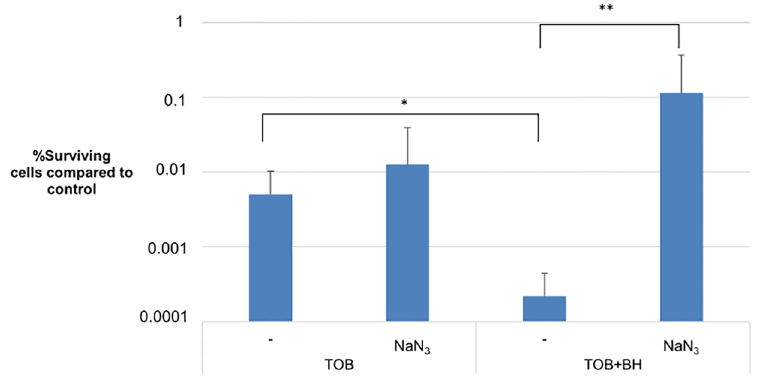
Fig 6. Effect of electron transport chain inhibition by NaN 3 on BH-mediated TOB potentiation. Percentage of surviving cells (±SD) after treatment compared to their respective controls (which received a pre-treatment but no antibiotic). Final concentrations of NaN 3 , BH and TOB were 150 μM, 250 μM and 1024 μg/ml (4 x MIC) respectively. Pre-treated cells received BH, NaN 3 , a combination of both or MHB for 4 hours. The experiment was conducted in triplicate. (cid:3) : significant difference (p < 0.05) between sessile cells not treated with NaN 3 . (cid:3)(cid:3) : significant difference (p < 0.05) between sessile cells when NaN 3 is included in the treatment.